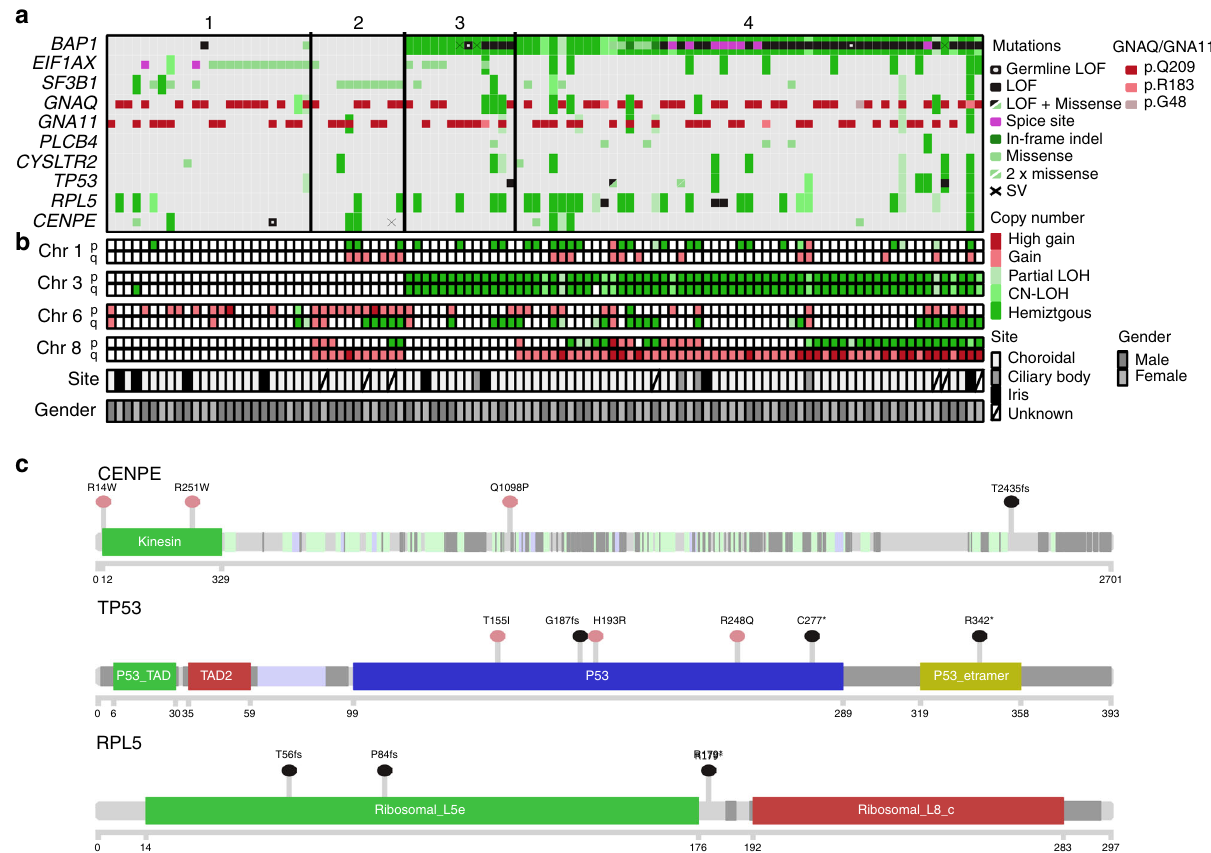
Fig. 3 Signi fi cantly mutated UM genes. Samples are arranged in the same order as Fig. 2 by their category (1 – 4). a Alterations (substitutions, indels, SVs and CNAs) in signi fi cantly mutated genes and known UM driver genes. Nonsense mutations and frame-shift indels are labelled LOF. Loss-of-function breakpoints due to structural variants are labelled SV. b Copy number status of the commonly aberrant chromosomes 1, 3, 6 and 8, in UM. c Positions of mutations in encoded protein of signi fi cantly mutated genes, CENPE , TP53 and RPL5 . Mutations are coloured black (LOF) and green (missense). Proteins domains are depicted wider and structurally important regions are coloured dark grey (disorder), light green (coiled-coil) and light blue (low complexity).